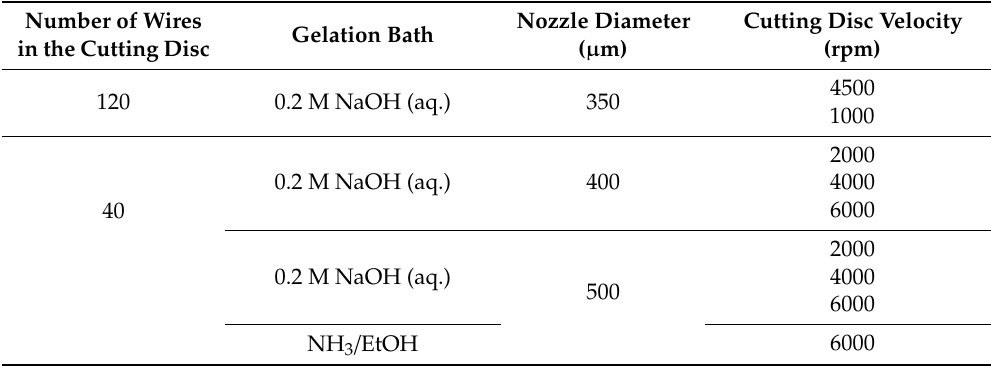
Table 1. Experimental jet cutting parameters tested for the processing of chitosan gel